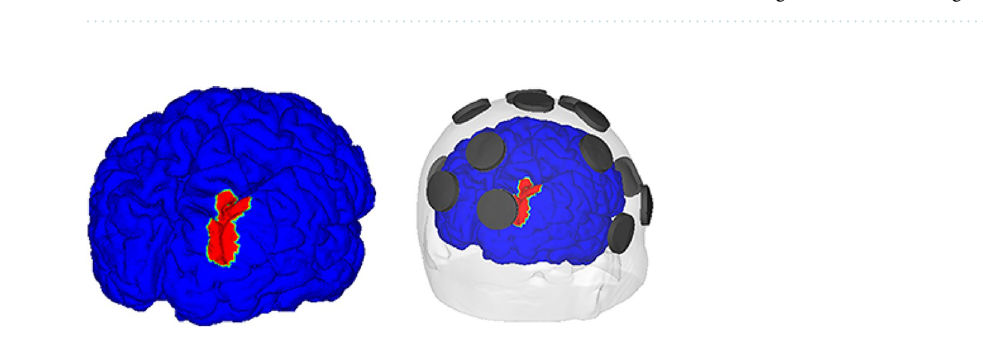
Table 1. Characteristics of electric field delivered and selected channels using 15 channel montages.